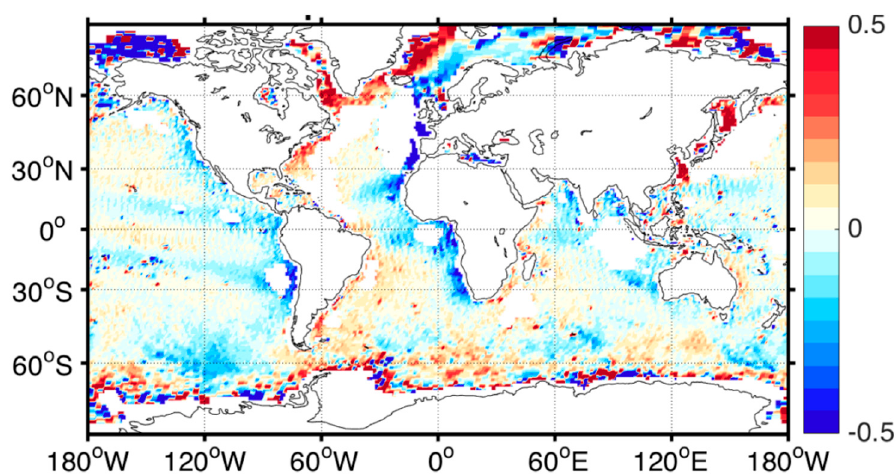
Figure 9. Forty-five-month average of ascending–descending data. Major bias regions are described in the text. The “white” regions in the North Atlantic, Western Pacific (China, Japan) or Indonesia are masked out due to suspected undetected radio frequency interference (RFI). See flagging/masking tables in [9] for details.